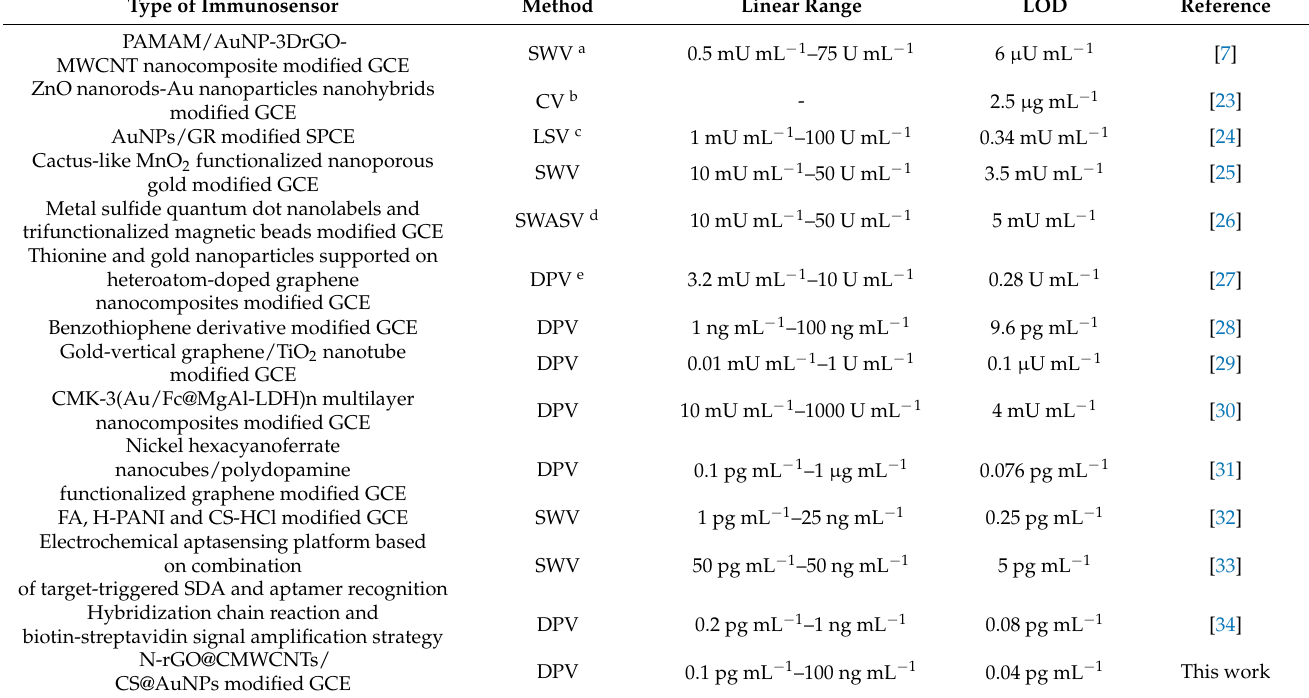
Table 1. Comparison of different electrochemical immunosensors for CA125 detection.